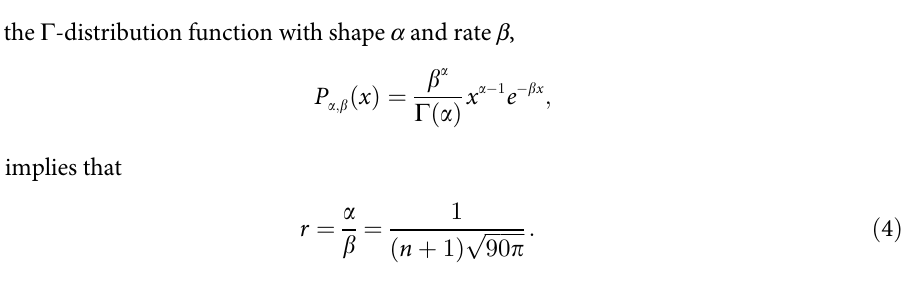
Fig 4. The radius distributions for the subdivision levels n = 5, 15 and 149 (from right to left). Note the logarithmic scale on the horizontal axis; the area under each curve is 1.